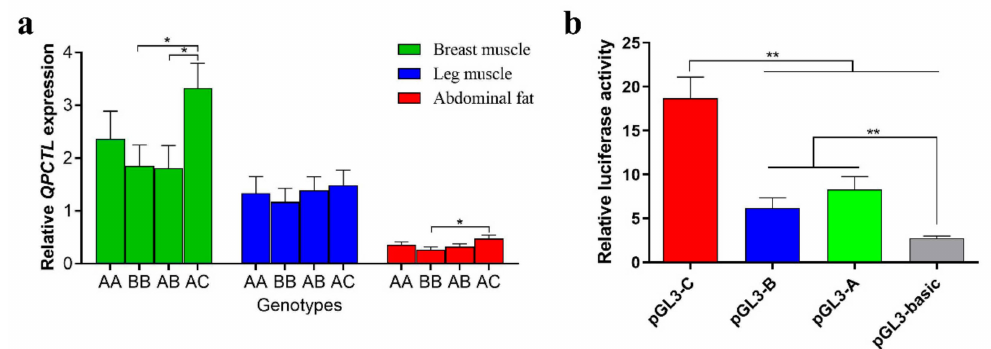
Figure 3. Effects of different Indels on QPCTL . ( a ) Expression of the QPCTL gene in breast muscle, leg muscle and abdominal fat of Gushi chickens with different genotypes ( n = 12). We did not collect sufficient tissues from CC and BC genotype individuals to compare the expression of all genotypes. ( b ) Luciferase activity in DF-1 cells transfected with recombinant plasmids. * p < 0.05; ** p <